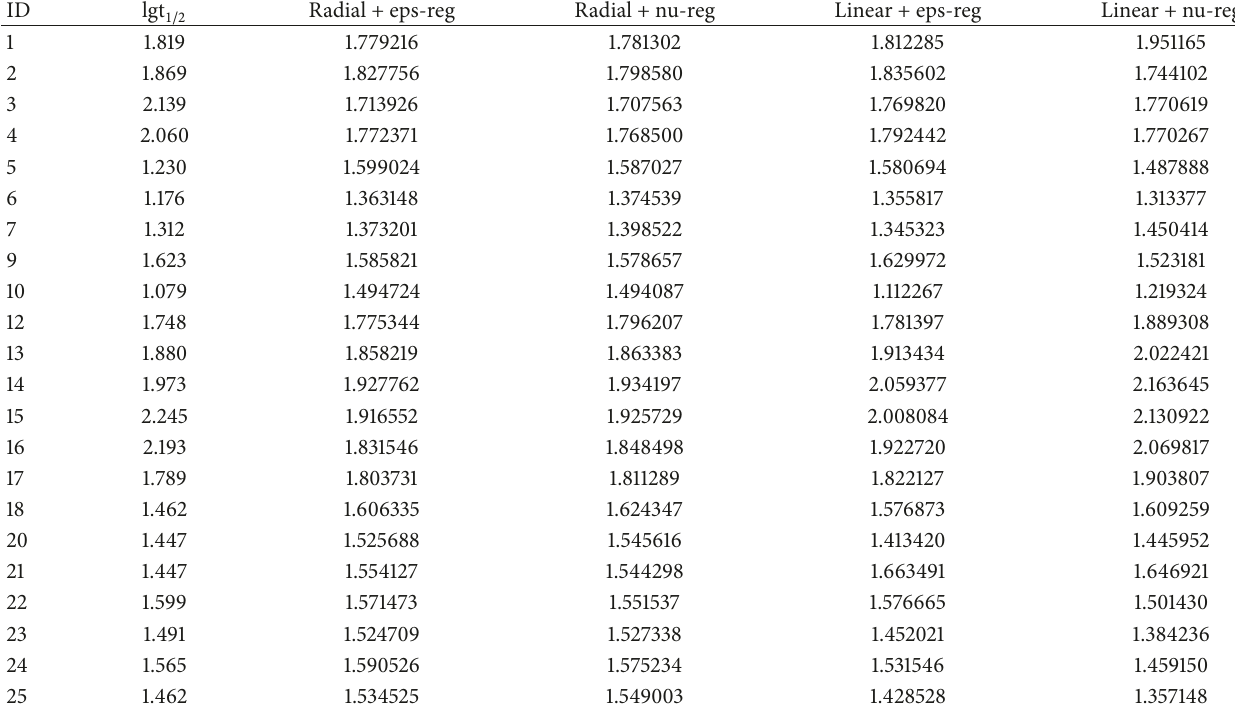
Table 5: Experimental values and 4 SVM models’ internal prediction results of lgt1/2.